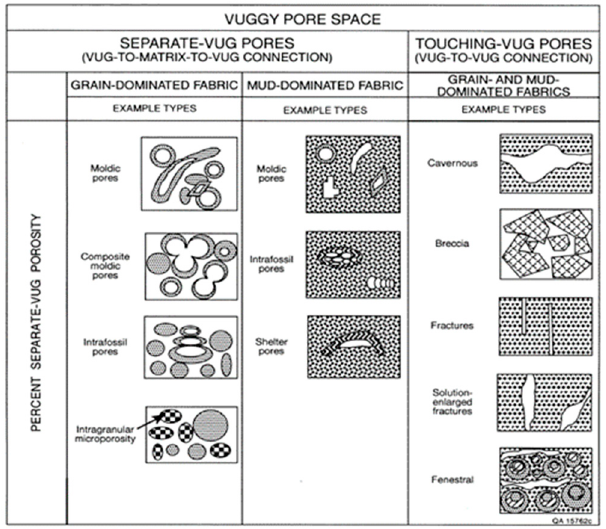
Figure 1. Geological and petrophysical classification of vuggy pore space based on interconnection [6].